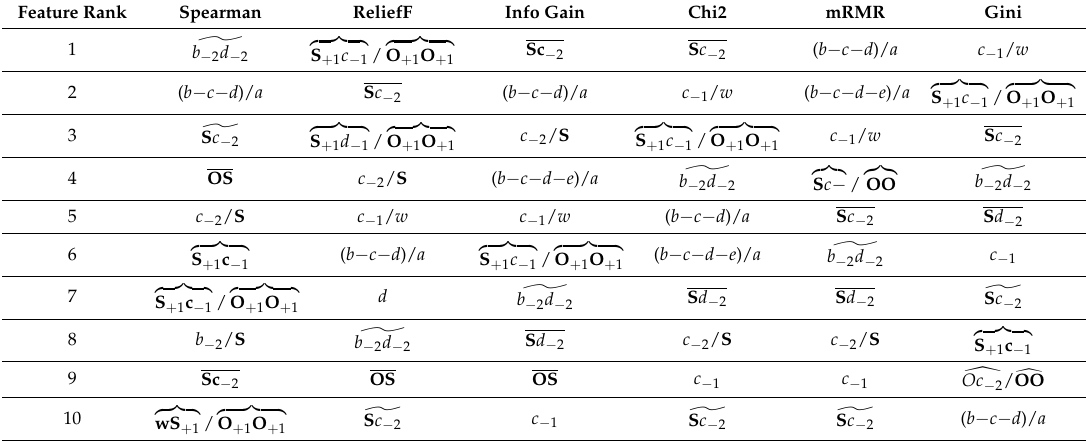
Table 2. The 10 selected features processed with six feature selection methods in hypertension risk stratification, which are ranked in descending